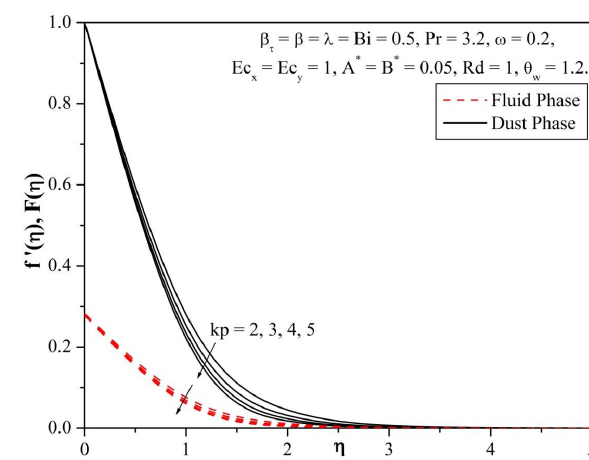
Fig. 2: Dimensionless profiles of u , u p velocity components for different values of k p .